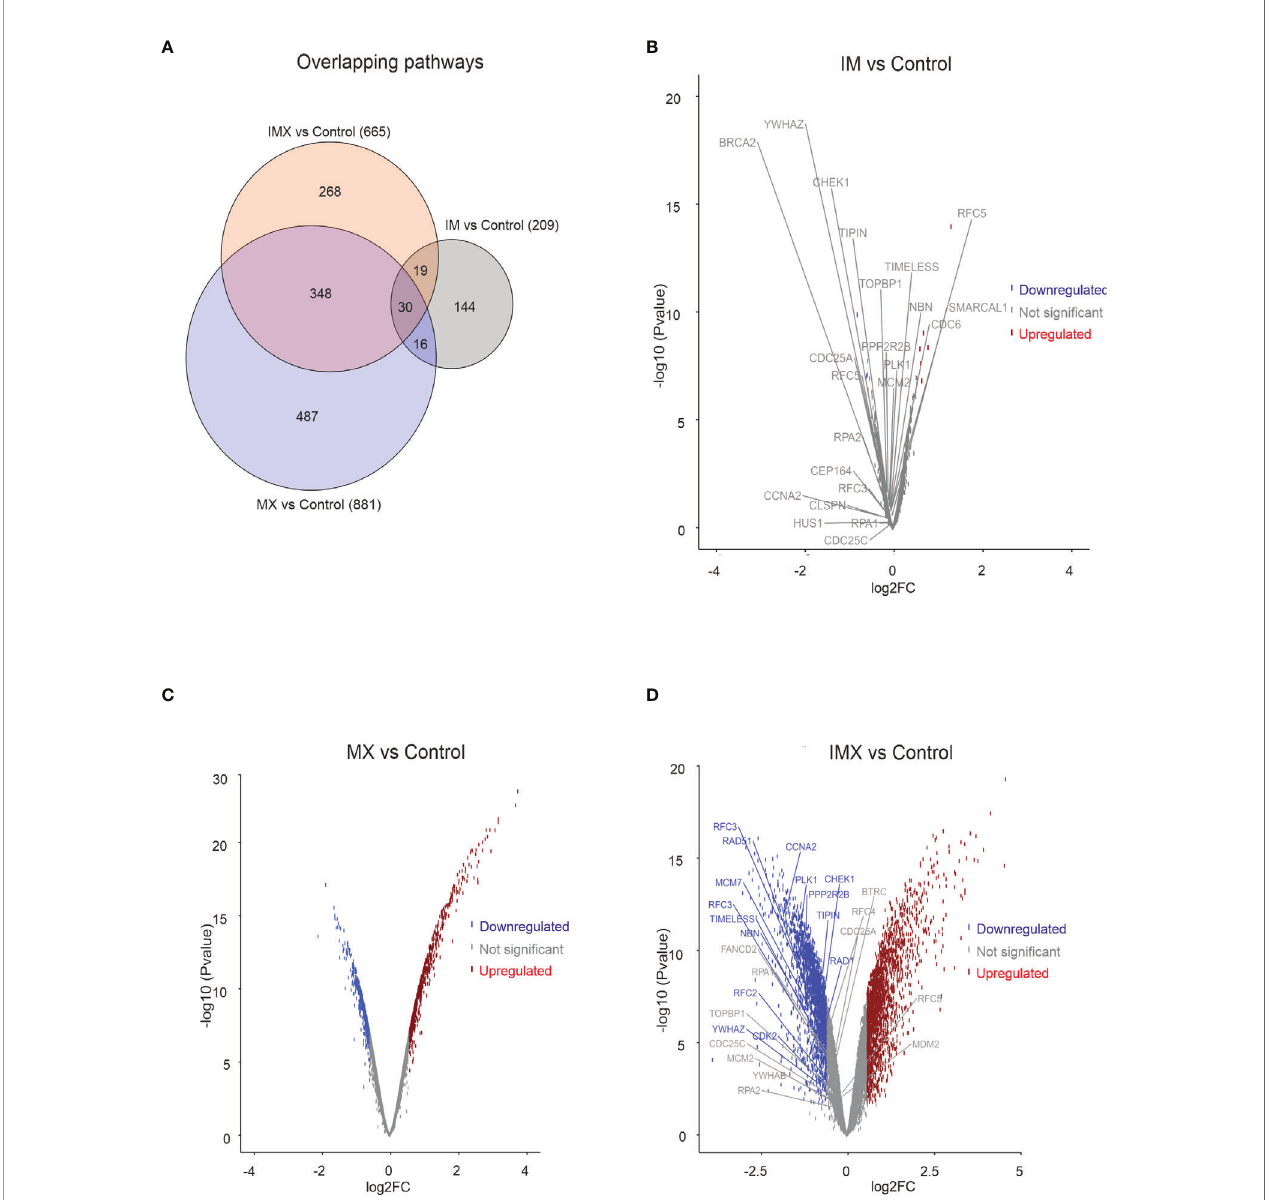
FIGURE 1 | Transcriptome analysis in HeLa cell line. HeLa cells were treated with either imatinib (IM), mitoxantrone (MX), or IM + MX (IMX). The hybridization set consisting of 18196 differentially expressed genes was run against 18425 gene sets in a gene set enrichment analysis platform (GSEA). (A) Euler diagram showing the overlapping pathways. FDR q-value of 0.1 was used as a threshold. (B – D) Volcano plots of whole probe set with log2 fold change of 0.58 (FC = 1.5) of differentially expressed genes. Their signi fi cance values p = 0.01 were used as threshold. Red dots represent upregulated and blue dots downregulated genes. Dots below threshold are greyed. ATR pathway was downregulated in both IM vs . C and IMX vs . C, and the leading edge genes are separately depicted. None of the leading edge genes in IM-treated cells reached the